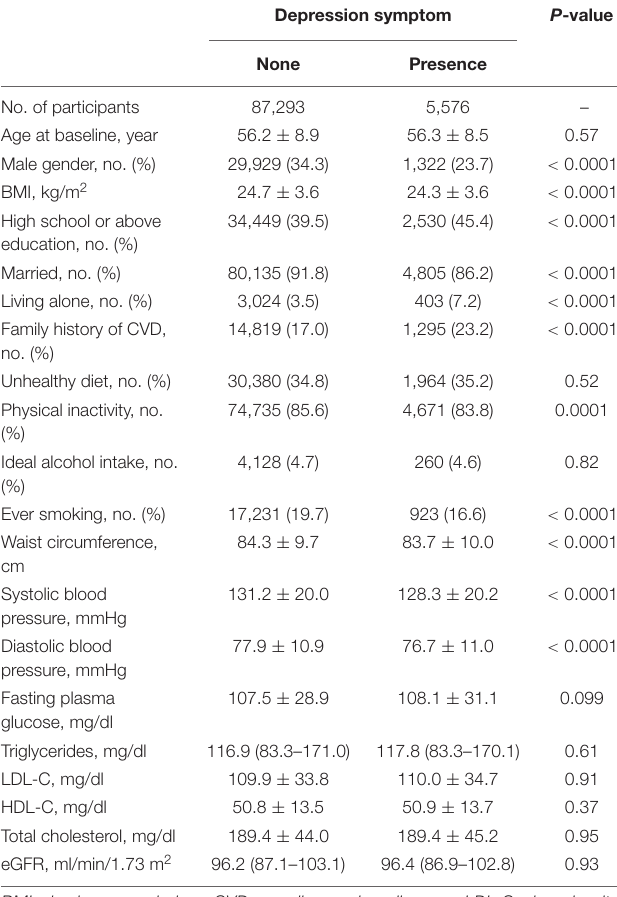
TABLE 1 | Baseline characteristics of the study population according to the baseline depression